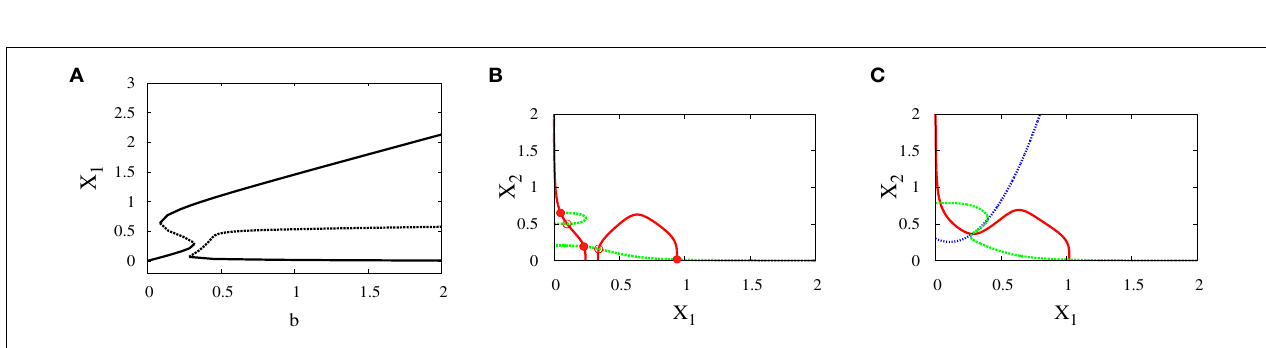
FIGURE 7 |Asymmetric scenario . Subcritical pitchfork bifurcation diagrams. Bifurcation diagram (A) and nullclines at the beginning (B) and end (C) of the bifurcation.The parameters are n = 4, r = 0.5, a 1 = 1.2, a 2 = 1, k 1 = 1.5, k 2 = 1.6.